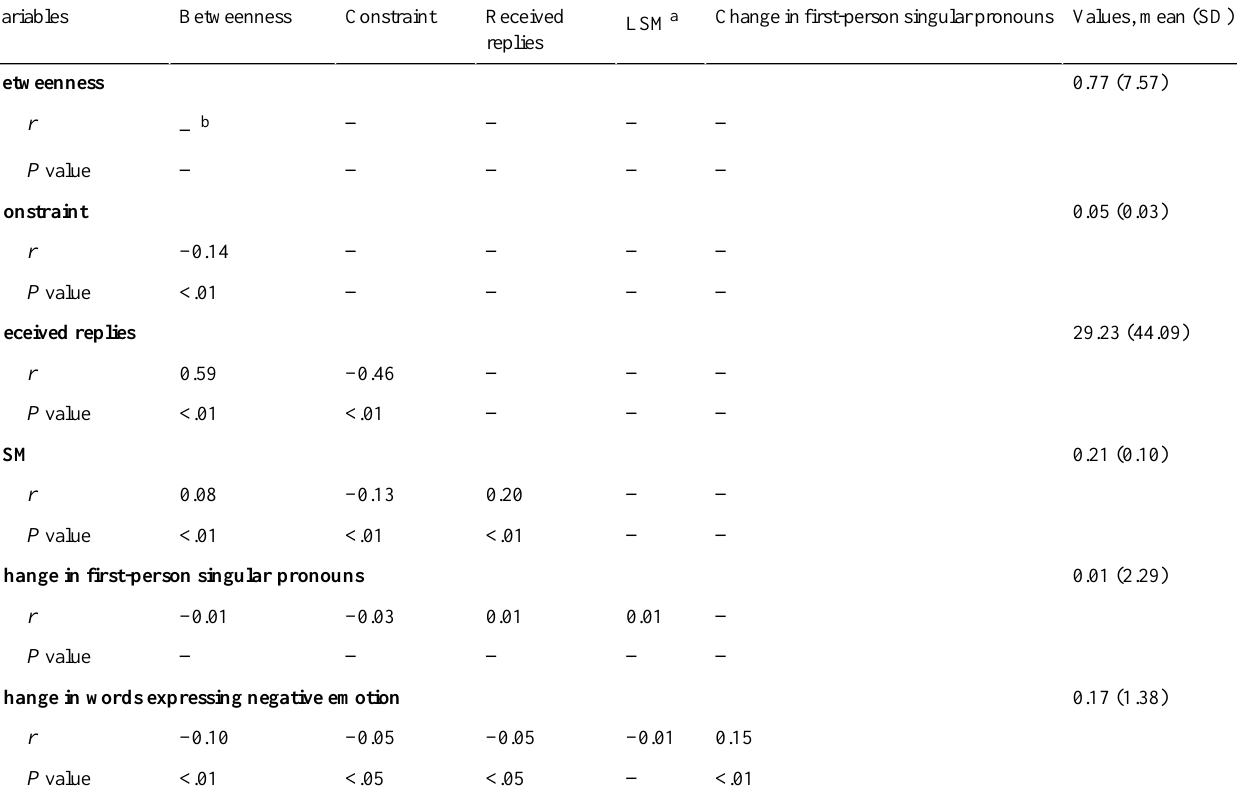
Table 2. Descriptive statistics and zero-order correlation among variables.